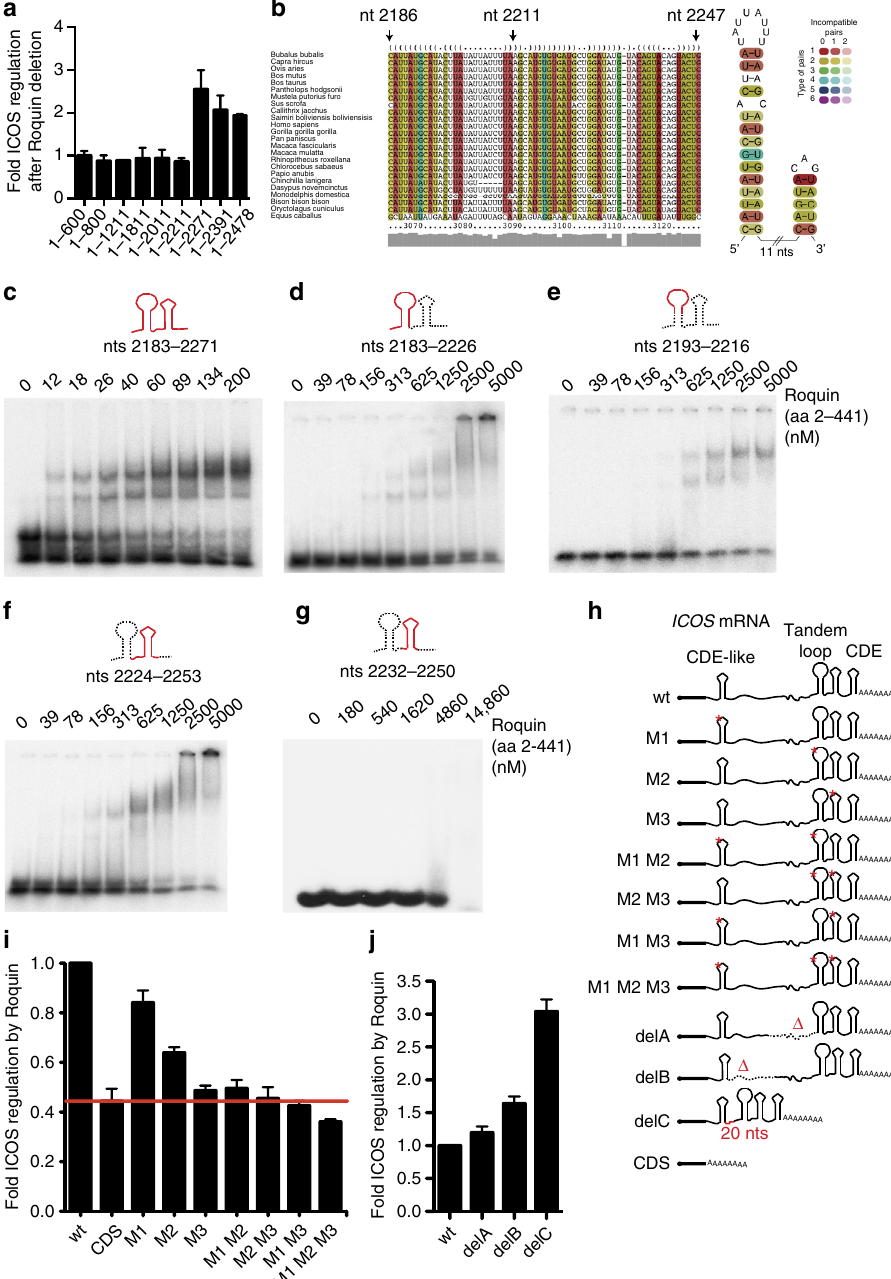
Fig. 7 An unconventional cis -element in the ICOS mRNA is recognized by Roquin and critical for post-transcriptional repression. a Reporter regulation of gradually shortened ICOS 3 ′ -UTR fragments in response to 4 ′ OH-tamoxifen (4 ′ OH-TAM) induced deletion of endogenous Roquin in Rc3h1 fl / fl ; Rc3h2 fl / fl ; Cre-ERT2 MEF cells. ICOS expression was quanti fi ed by fl ow cytometry. Fold regulation was determined by dividing (ICOS MFI +4 ′ OH-TAM)/(ICOS MFI – 4 ′ OH-TAM) and normalized to the regulation of ICOS 1 – 600 (CDS). b Sequence-structure alignment of the putative Roquin-active ICOS cis -element and consensus secondary structure of putative Roquin-binding stem-loop motifs are shown. The number of different types of base pairs for a consensus pair is indicated by different colors, the number of incompatible pairs by the saturation of the consensus base pair. A consensus secondary structure is depicted on the right. c – g Electrophoretic mobility-shift assays (EMSAs) with increasing amounts of Roquin-1 (aa 2 – 441) incubated with ICOS RNA fragments as indicated. Labeled in red is the part of the consensus secondary structure shown in b that is included in the respective ICOS RNA fragment. g At the highest protein concentration unspeci fi c RNA binding was observed, as detected by a broad smear of retarded RNA. h Schematic representation of ICOS reporter constructs bearing mutant stem-loops. Mutations designed to destroy the secondary structure of selected RNA elements are indicated by asterisks. i , j Reporter regulation of the stem-loop and deletion mutants from h in response to 4 ′ OH-TAM induced deletion of endogenous Roquin in Rc3h1 fl / fl ; Rc3h2 fl / fl ; Cre-ERT2 MEF cells. Fold regulation was determined by dividing (ICOS MFI +4 ′ OH-TAM)/(ICOS MFI – 4 ′ OH-TAM) and normalized to the regulation of ICOS wt. Error bars in a , i and j indicate mean and SDs of two ( a ) or four ( i , j ) independent experiments. In c – g representatives of three independent experiments are